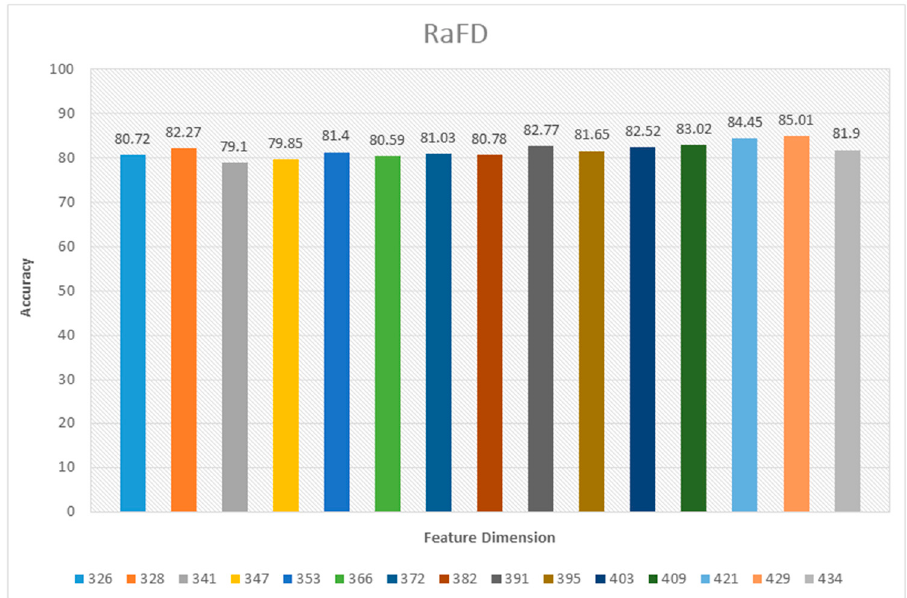
Figure 8. Graphical representation of the dimensions and accuracy scores (%) of the reduced-feature subsets in HM for PHOG-based feature vector extracted from images of dimension 32 × 32 in RaFD dataset, where distinguishable colors denote di ff erent feature dimensions of the reduced-feature subsets